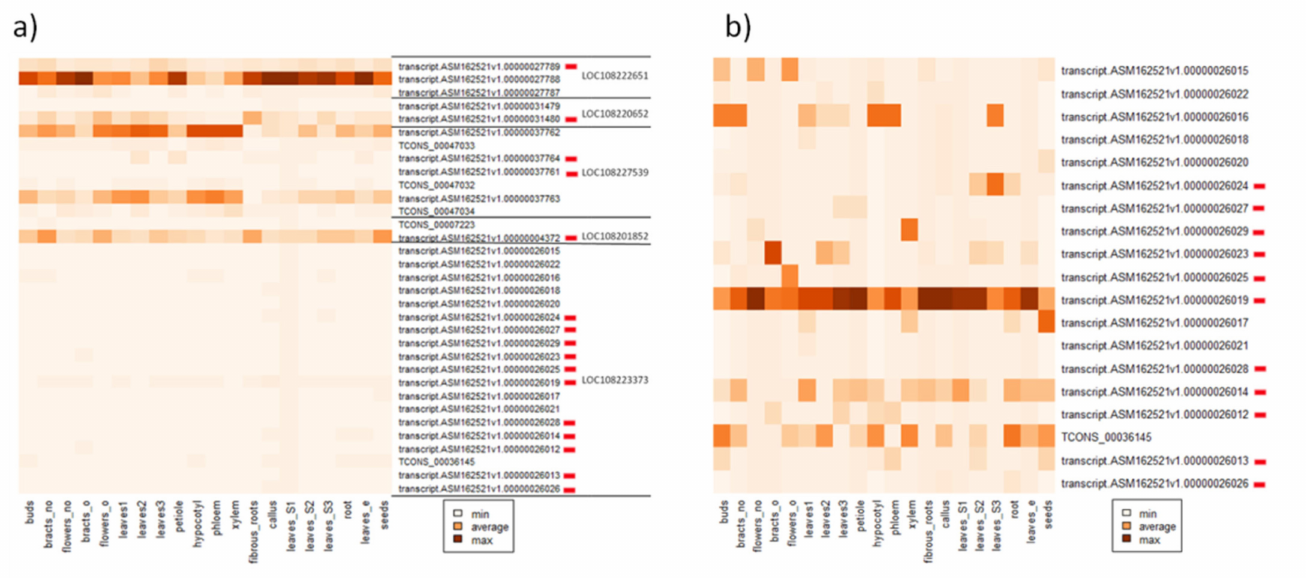
Figure 3. Heatmap of the expression (TPM, transcript per million) of five genes ( a ) and LOC108223373 ( b ) producing hAT -containing isoforms (labeled by red rectangles). Expression was normalized by tissue type to allow comparisons between genes and isoforms. Novel isoforms are labeled as TCONS_XXX. Detailed results/descriptions are provided in Supplementary File S3.